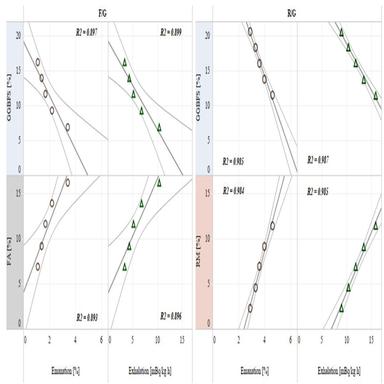
The measured emanation and exhalation properties compared with the fly ash (FA), red mud (RM) and ground granulated blast furnace slag (GGBFS) content in the fly ash and ground granulated blast furnace slag (F/G) and red mud and ground granulated blast furnace slag (R/G) series where the trendlines were placed with 95% confidence bands.